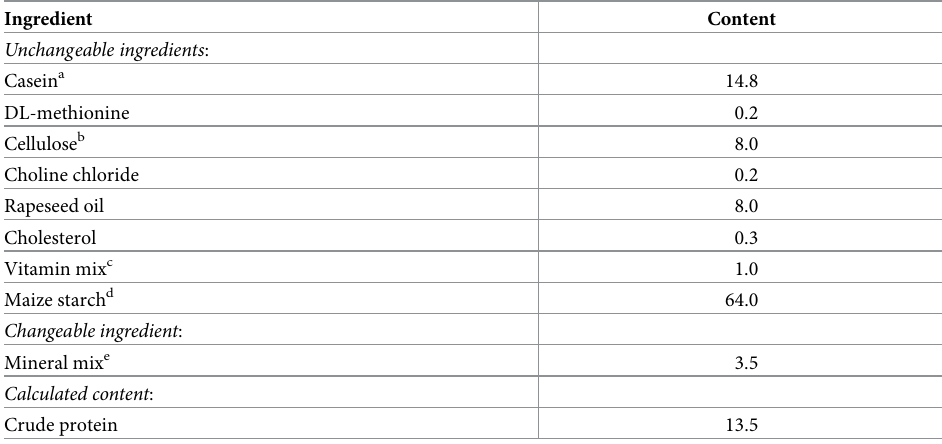
Table 1. Composition of basal diet fed to rats, %.